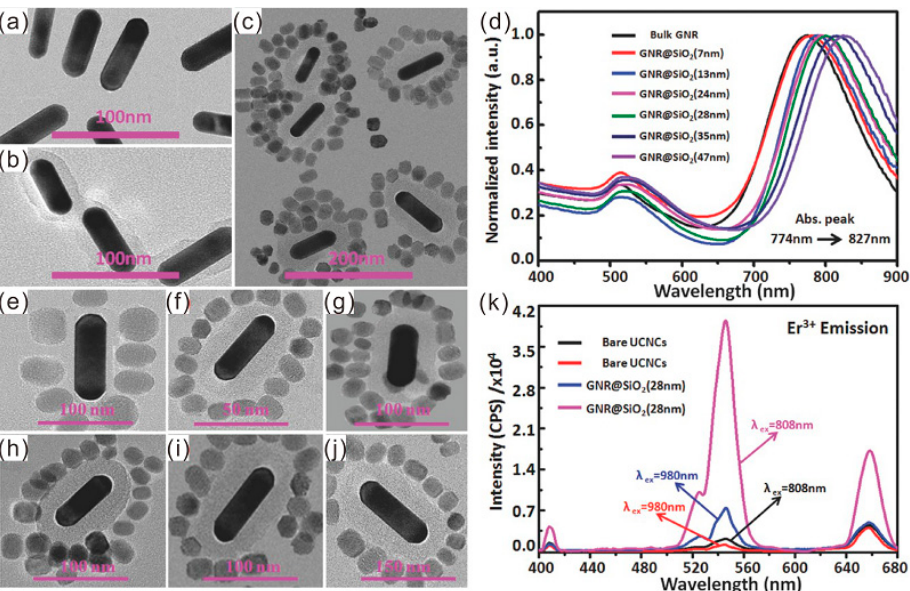
Figure 7. Low-magnification TEM images of as-prepared bare ( a ), SiO 2 -coated Au NRs ( b ), and hybrid AuNR@SiO 2 @NaGdF 4 :Yb, Nd@NaGdF 4 :Yb, Er@NaGdF 4 nanostructures with 28-nm SiO 2 thickness ( c ). ( d ) Measured extinction spectra of AuNR@SiO 2 core–shell nanostructures with SiO 2 shell thickness varied from 0 to 47 nm; ( e – j ) TEM images of single hybrid AuNR@SiO 2 @NaGdF 4 :Yb, Nd@NaGdF 4 :Yb, Er@NaGdF 4 nanostructures with SiO 2 thickness varied from 7 nm to 47 nm; ( k ) Measured luminescence spectra for bare UCNPs and hybrid nanostructures of 24-nm SiO 2 shell under 808 nm (black and pink) and 980 nm (red and blue) continuous wave (CW) laser excitation. Note that the TEM image in (i)